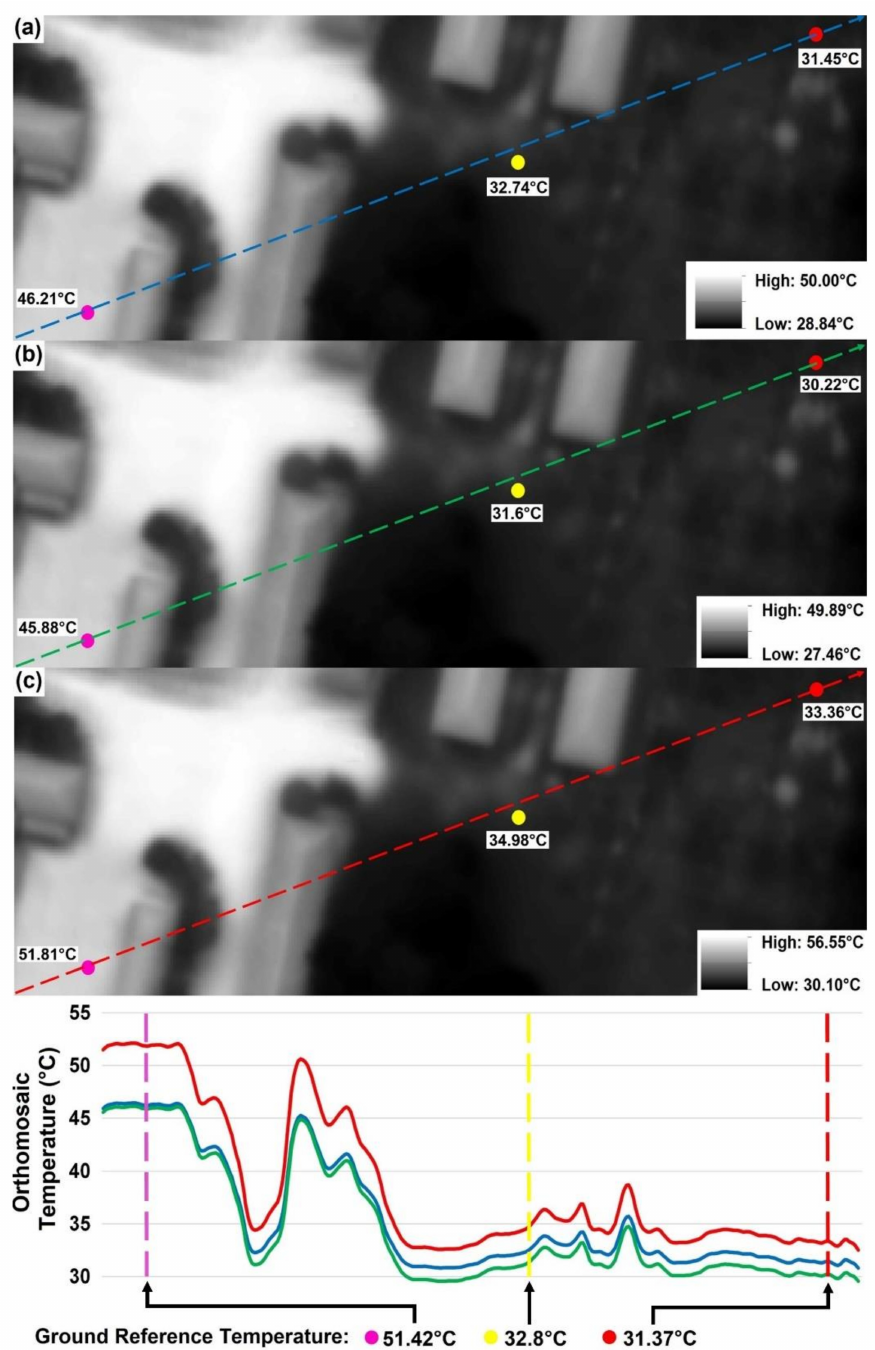
Figure 9. Zoomed view of the area based on orthomosaic from mission E, with temperature data calibrated with the factory ( a ), proximal ( b ) , and general model ( c ). The profile graph illustrates temperature values along the transect from orthomosaics calibrated with the above-mentioned models. Dashed lines indicate where along the transect the reference targets (colored dots) are